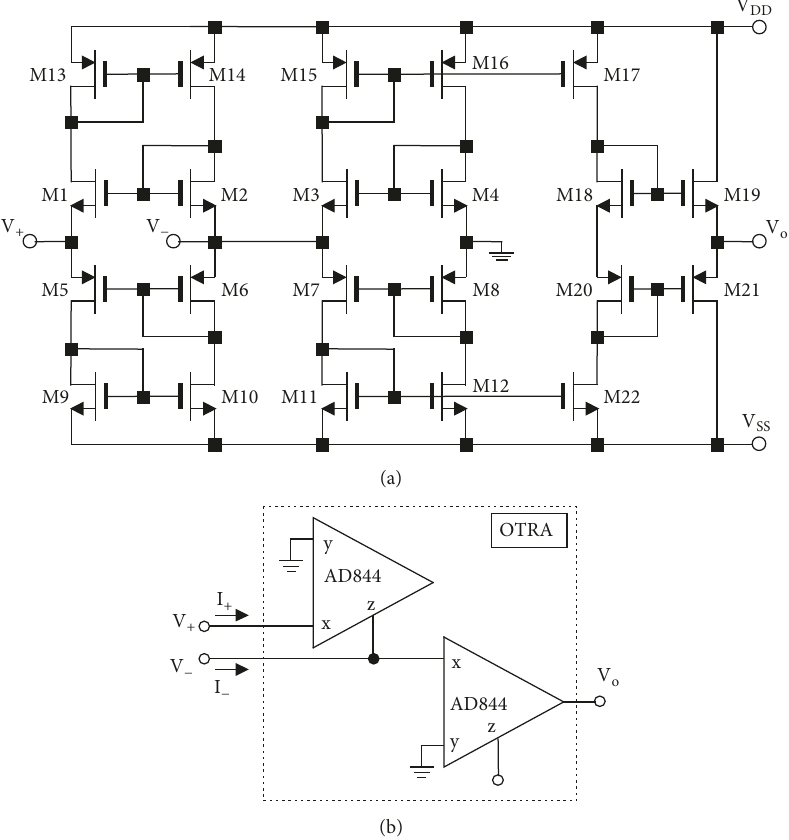
Figure 2: OTRA implementation based on (a) CMOS transistor-level and (b) integrated circuits